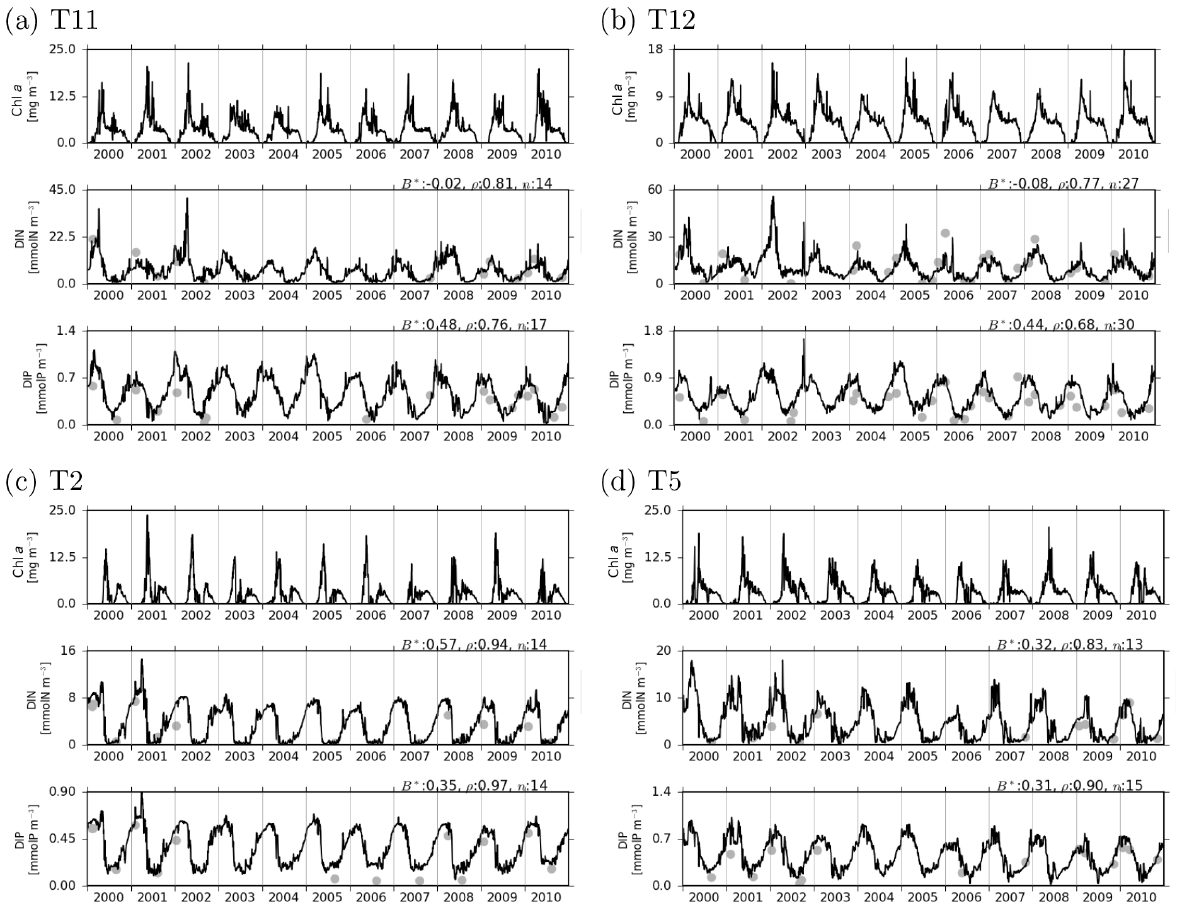
Figure 7. As in Fig. 5, but for the offshore monitoring stations operated by the Bundesamt für Seeschifffahrt und Hydrographie.